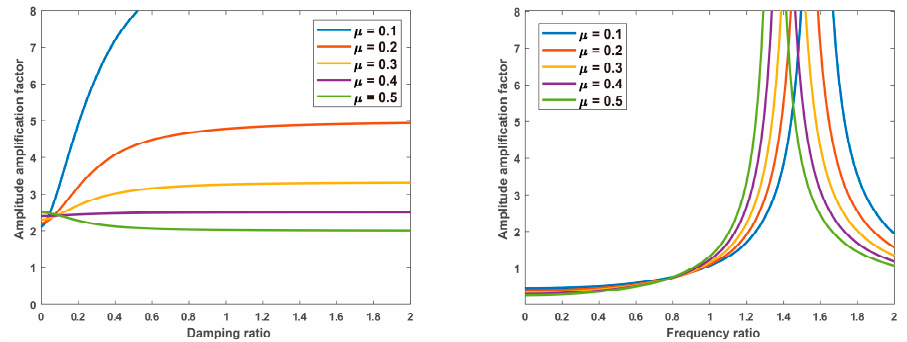
Figure A2. The influence of the inertia ratio µ on amplitude and frequency. As shown in Figure A2, when the damping ratio is large, the torsional amplitude of the shafting system will decrease with the increase of the inertia ratio. In addition, the natural frequency of the shafting system will decrease with the increase of the inertia ratio. factor and also has a certain degree of in fl uence on the frequency shift of the system. magnetic circuit structure of the MR-TVA and subsequent optimization.